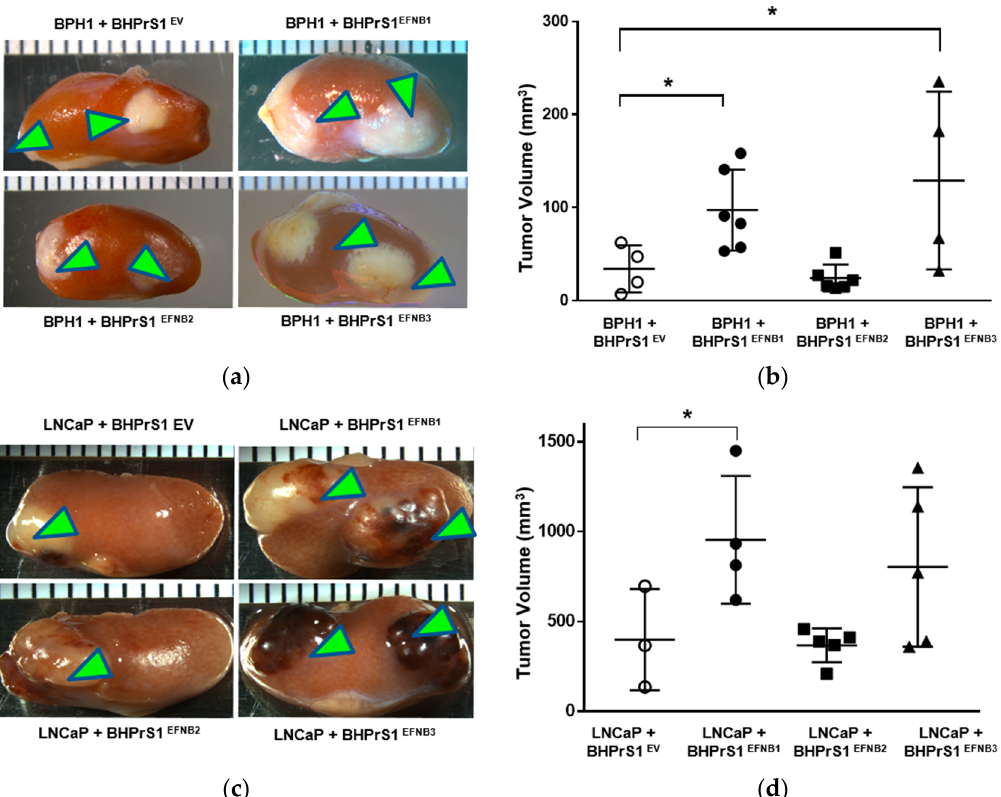
Figure 4. Overexpression of Ephrin B (EFNB) ligands in normal prostate fibroblasts induces in vivo prostate cancer tumorigenicity in SCID xenografts. ( a ) Gross morphology of grafts composed of BPH1 cells with EFNB ligands-overexpressing BHPrS1 cells (BHPrS1 EV , BHPrS1 EFNB1 , BHPrS1 EFNB2 , BHPrS1 EFNB3 ). ( b ) The size of BPH1 tumors in each sample are shown as dot plots with mean ± SEM (* p < 0.05, n = 4 or 6, one-way ANOVA). ( c ) Gross morphology of grafts composed of LNCaP cells with EFNB ligands overexpressing BHPrS1 cells (BHPrS1 EV , BHPrS1 EFNB1 , BHPrS1 EFNB2 , BHPrS1 EFNB3 ). ( d ) The size of LNCaP tumors in each sample are shown as dot plots with mean ± SEM (* p < 0.05, n = 3 or 5, one-way ANOVA). Green arrowheads point the tumor on kidney.